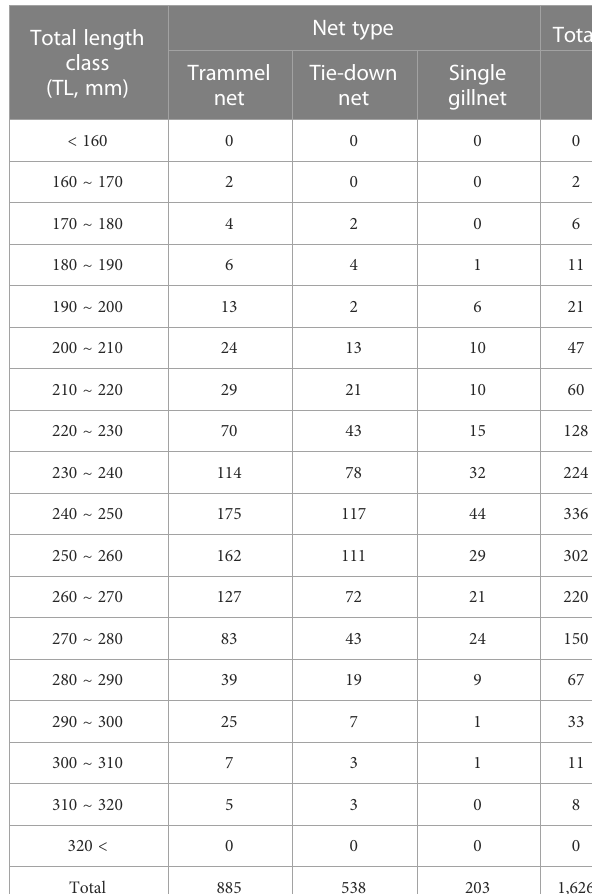
TABLE 3 Length frequency distribution of black fi n fl ounder caught by experimental